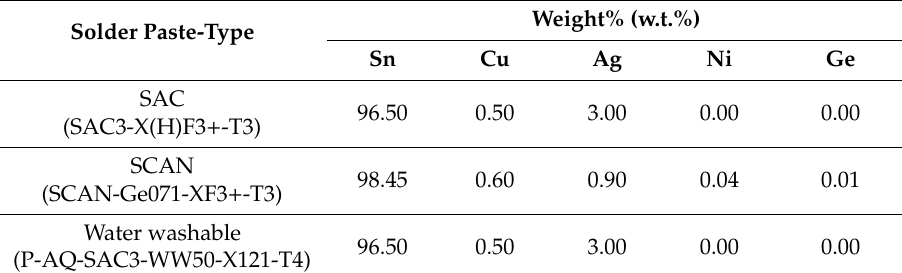
Table 1. Chemical compositions for di ff erent solder pastes